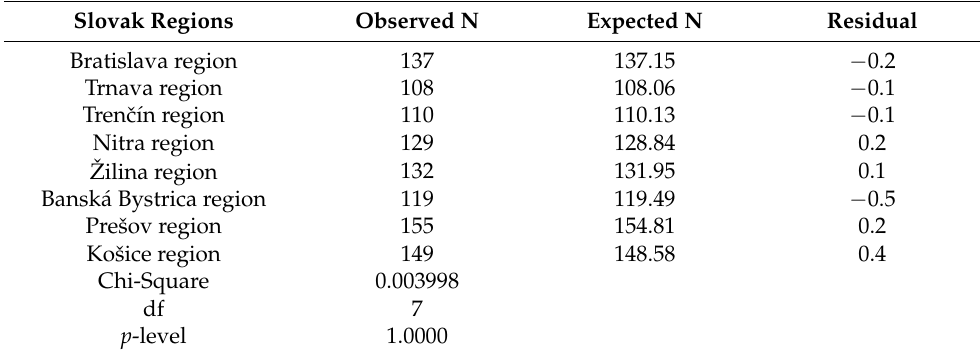
Table 2. Results of the nonparametric chi-square test. Slovak